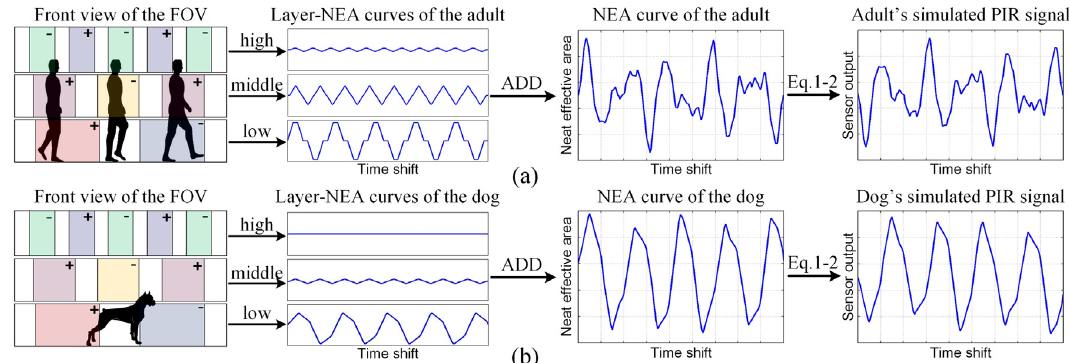
Figure 2. Simulation of the adult’s ( a ) and the dog’s ( b ) PIR signals, where the squares with the symbol “+” in the front view of FOV indicate the PSZs and those with the symbol “ − “ indicate the NSZs, the blank between PSZ and NSZ indicates the PSZs.